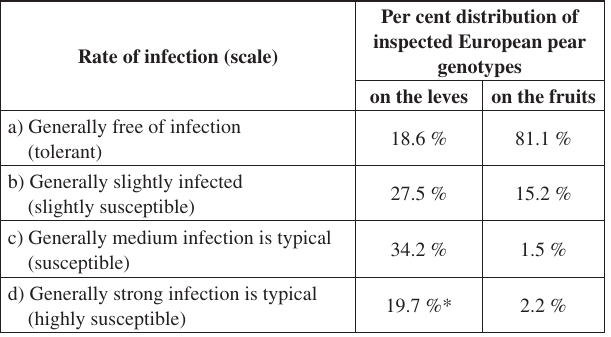
Table 4. European pear genotypes being tolerant or slightly susceptible to Veturia pirina fi eld infection, after research made in Hungary Both the leaves and the fruits Maximum fi eld Scarcely infection is always susceptible less than 10 per cent after Husz (1941) after Szabó and Soltész (1998)